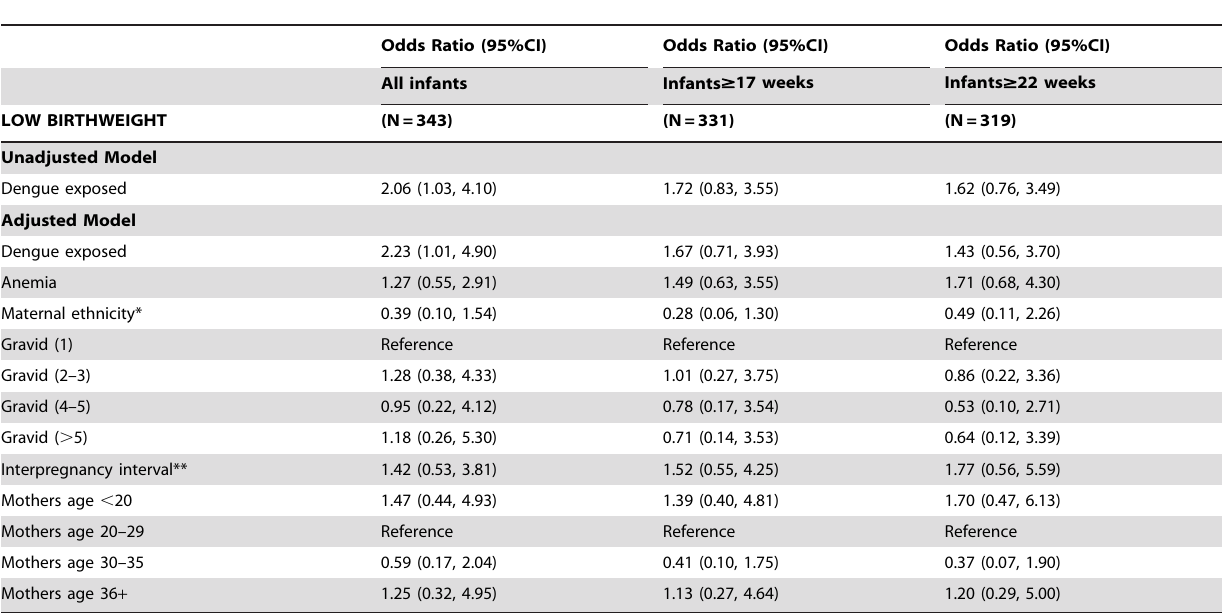
Table 5. Odds ratios for low birthweight among those with and without symptomatic dengue